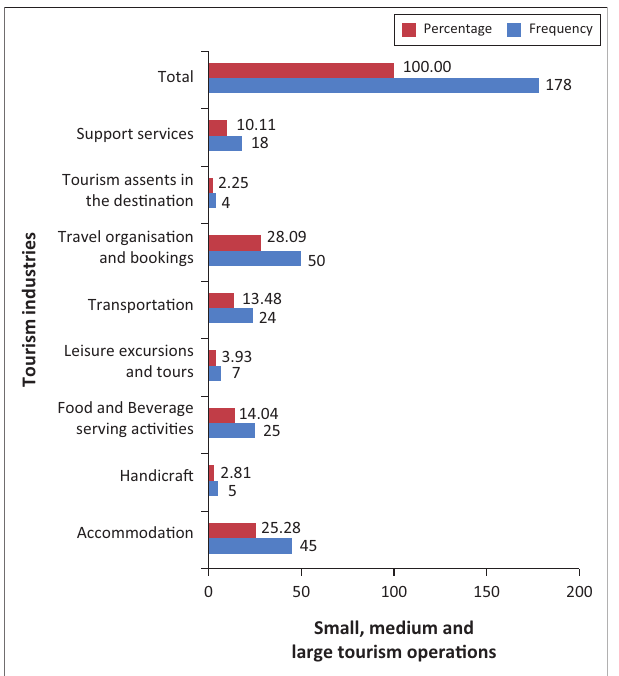
FIG URE 3: Descriptive statistics of the tourism operations in Pretoria.